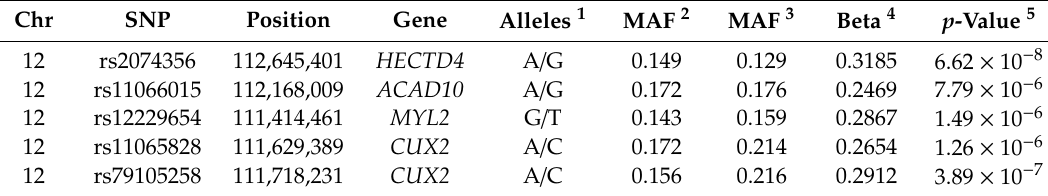
Figure 4. Linkage disequilibrium (LD) plot of the 18 significant SNPs discovered from the GWAS on coffee consumption. Values shown in the red boxes represent the LD (r 2 ) between the SNPs. Table 2. SNPs related to coffee consumption ( p -value < 1 × 10 − 5 ).